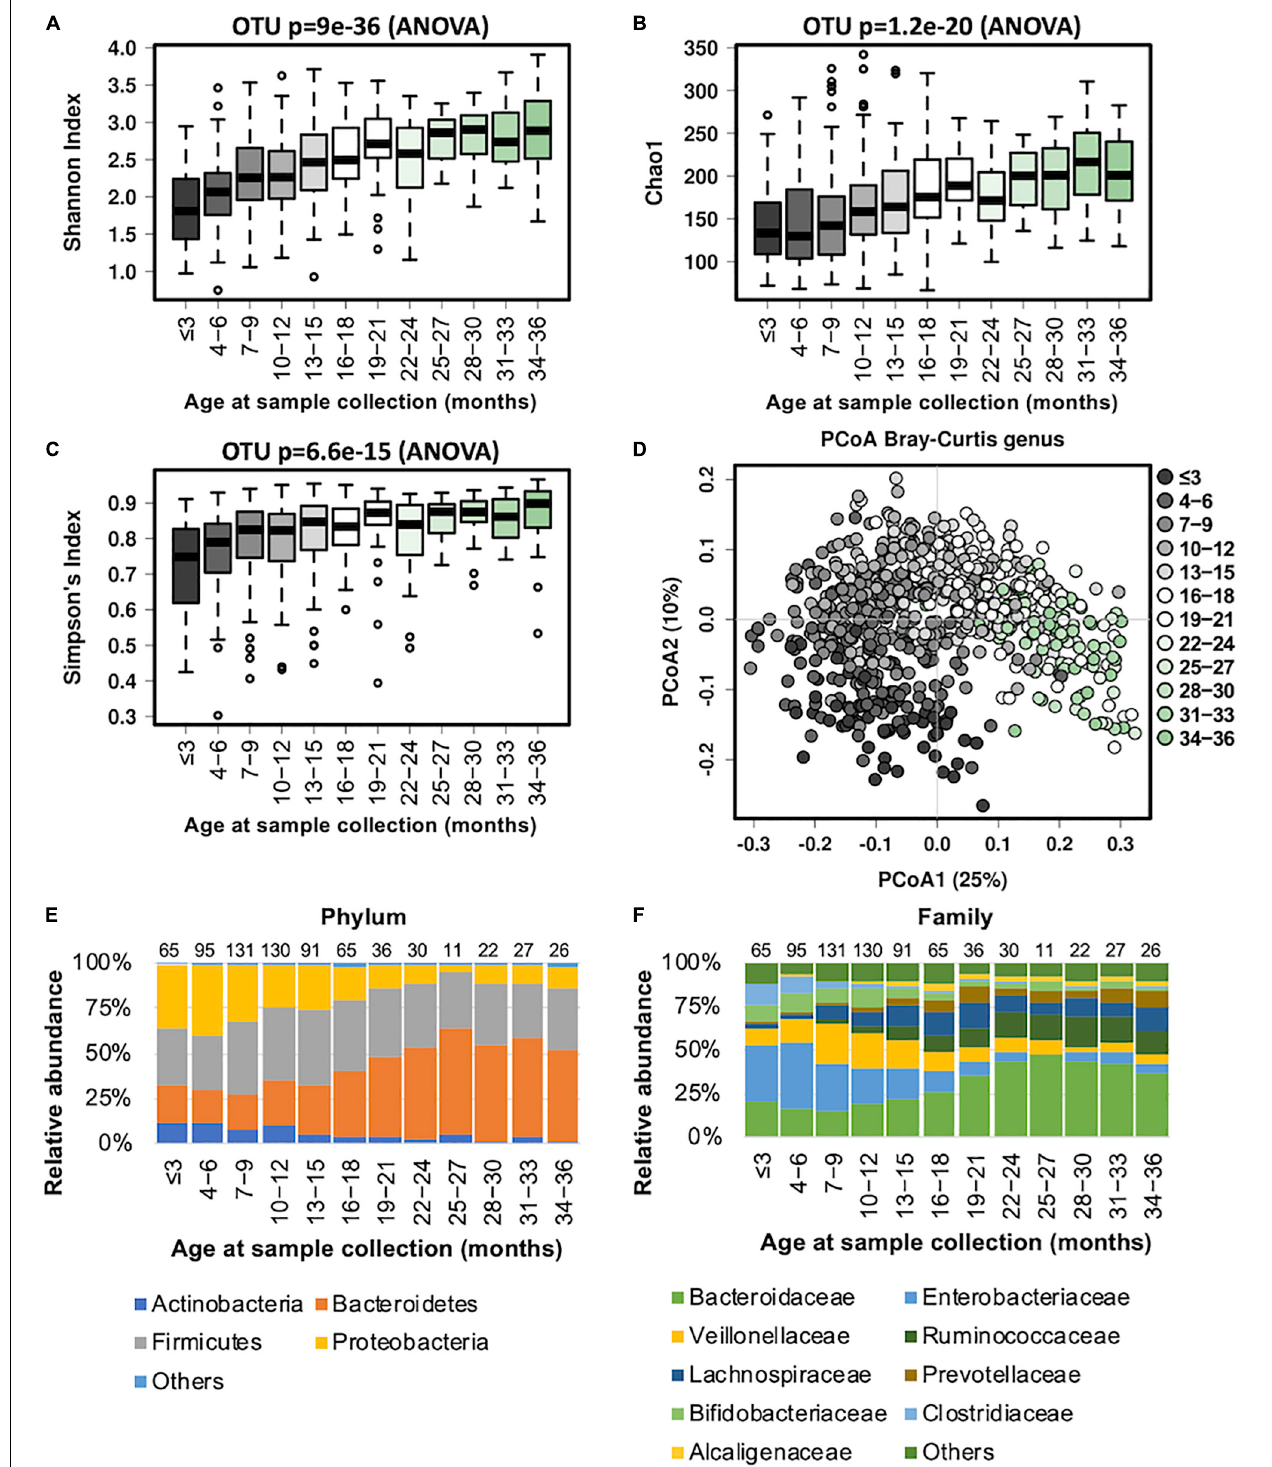
FIGURE 1 | Fecal microbiota diversity and composition for 729 children according to age (0–3 years). Longitudinal alpha diversity from 0 to 36 months of age was measured by (A) Shannon index, (B) Chao1, and (C) Simpson’s index. (D) PCoA of Bray–Curtis distance based on the genus level. Each sample is colored according to age. Evolution of the gut microbiome at the (E) phylum and (F) family levels alongside physiological development. Number of children per age group is provided above bars.